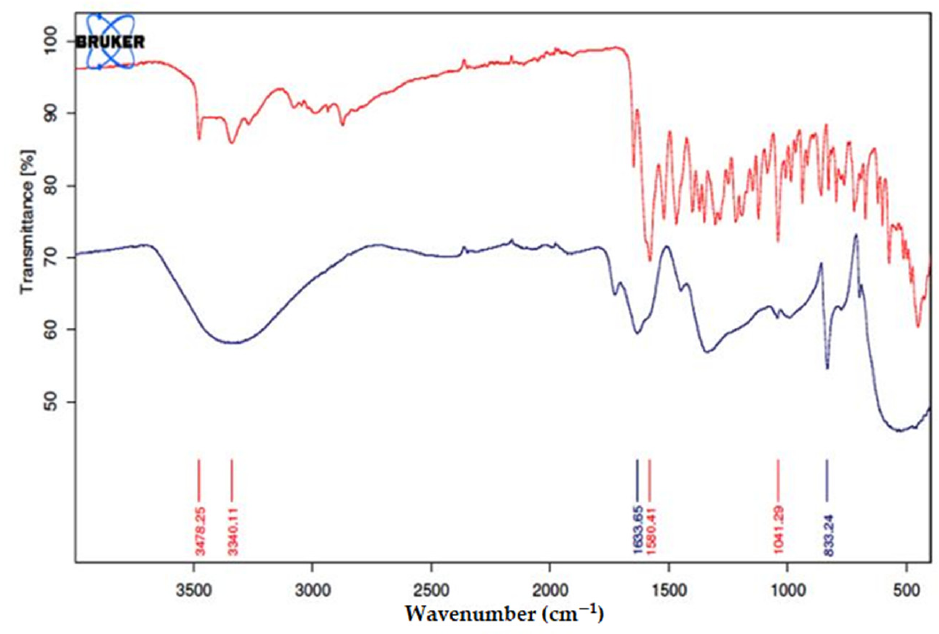
Figure 5. FT-IR Spectra of minocycline (Red) and minocycline-modified silver nanoparticles (Blue).